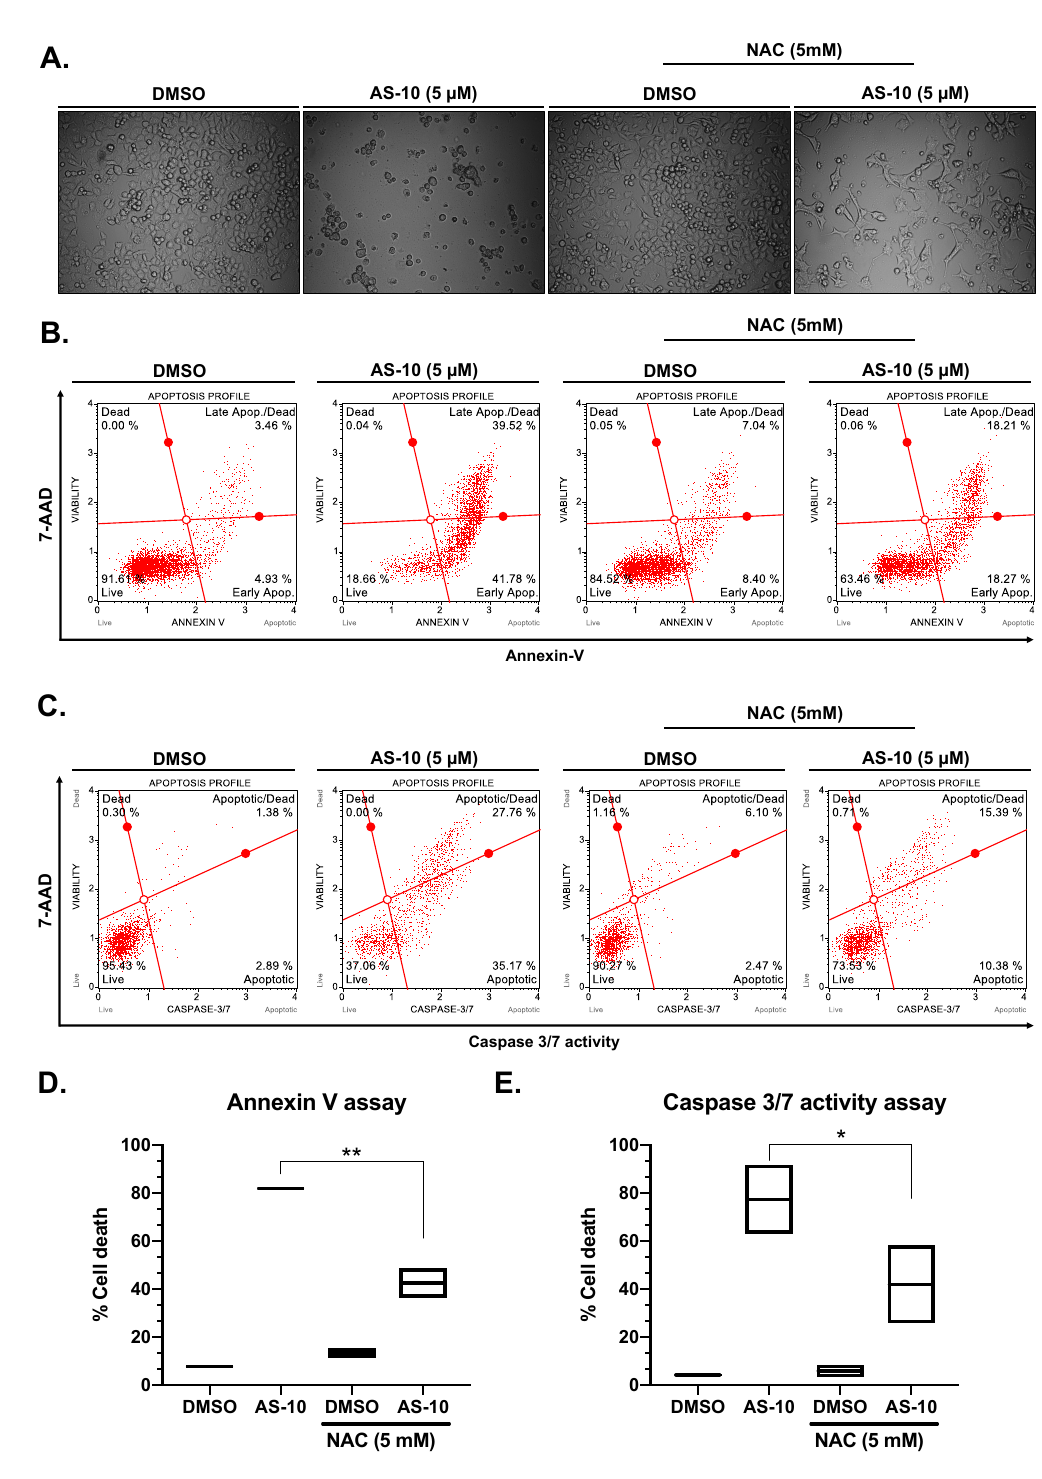
Figure 3. N-acetyl cysteine (NAC) attenuated AS-10-induced apoptosis of Panc-1 cells. Panc-1 cells were pre-treated with NAC for 2 h (in the NAC group) and then co-treated with DMSO or AS-10, for 48 h. After 48 h, cells were subjected to ( A ) light microscopy; ( B ) Muse Live/dead Annexin V assay; and ( C ) Muse Caspase 3/7 activity assay. ( B , C ) Representative histograms show four quadrants for estimating live, necrotic, and apoptotic death fractions: bottom-left quadrant (live cells (7-ADD (-), Annexin V (-) or Caspase 3/7 (-))); bottom-right quadrant (Early apoptotic (7-ADD (-), Annexin V (+) or Caspase 3/7 (+))); top-right quadrant (Late apoptotic/dead cells (7-ADD (+), Annexin V (+), Caspase 3/7 (+))); top-left quadrant (necrotic (7-ADD (+), Annexin V (-), Caspase 3/7 (-))).( D , E ) Total apoptotic cells (early + late apoptotic cells) measured by Muse Annexin V assay ( D ) and Muse caspase 3/7 activity assay ( E ). Data represents mean ± SD * ( p < 0.05); ** ( p <